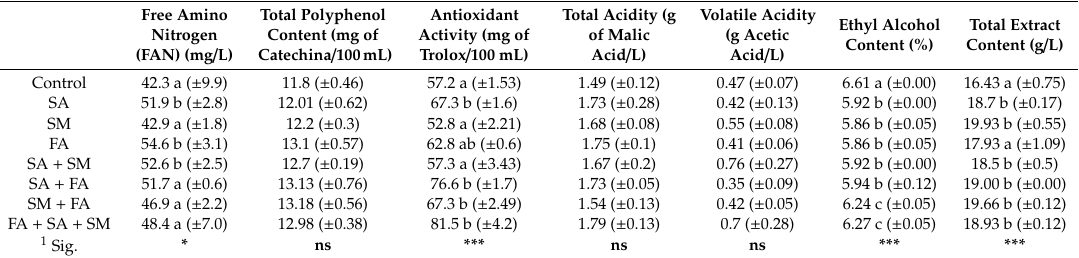
Table 8. Physicochemical parameters for ciders fermented by wild yeast (D), with the following additions: SA—ammonium sulfate, SM—magnesium sulfate, FA—ammonium phosphate. Free Amino